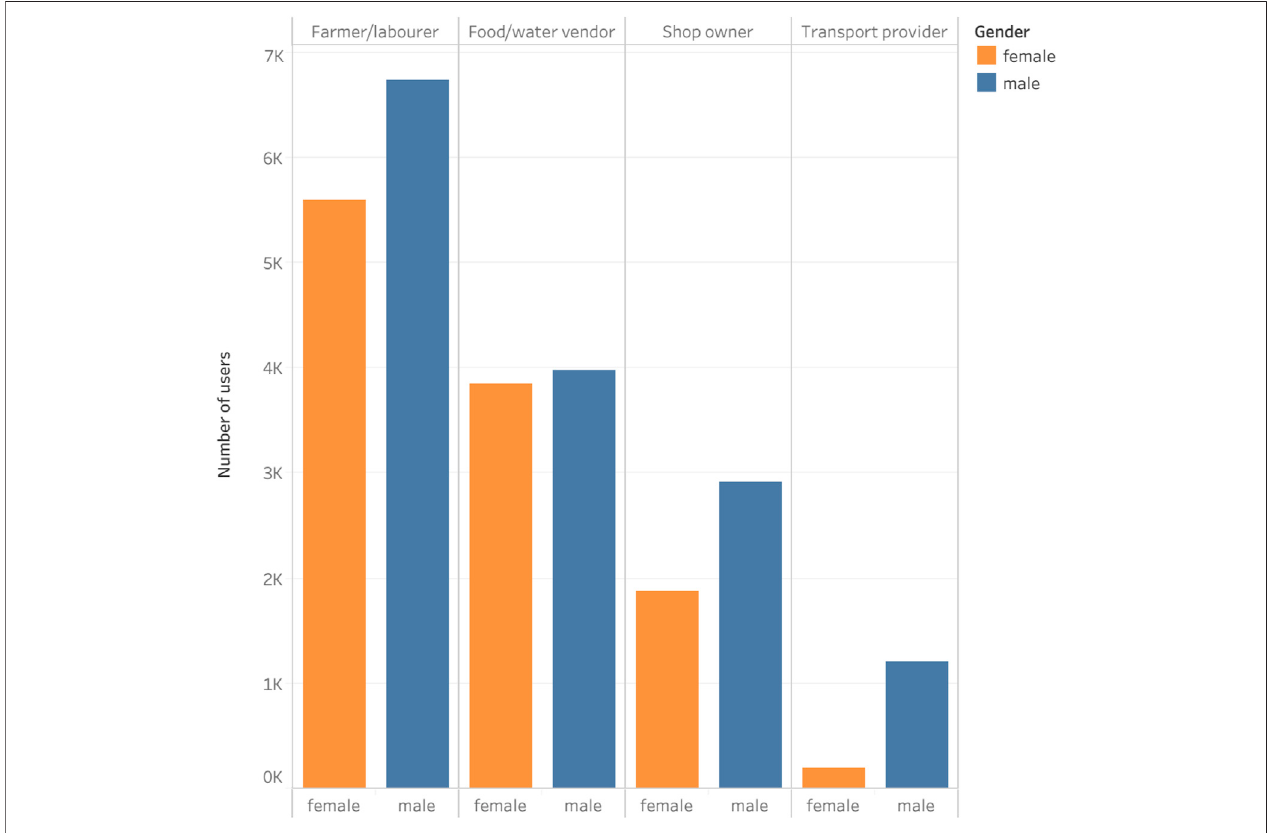
FIGURE 10 | User roles by gender (Grassroots Economics,